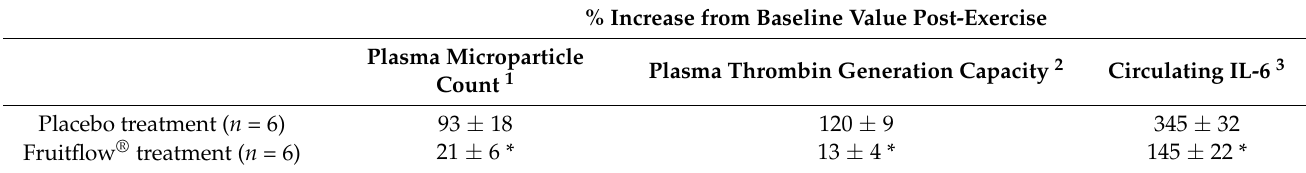
Table 1. Post-treadmill exercise effects on platelet activation, coagulation and inflammation in men aged 18–55 ( n = 6). % Increase from Baseline Value